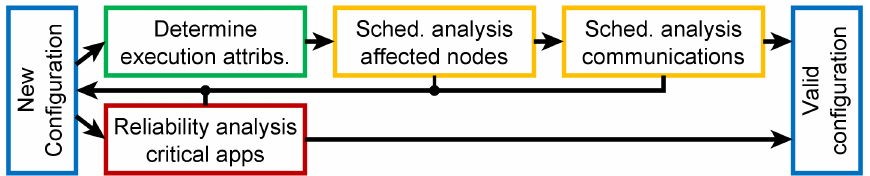
Figure 8. Diagram of the first search approach where the assessment of the real-time and reliability requirements is done